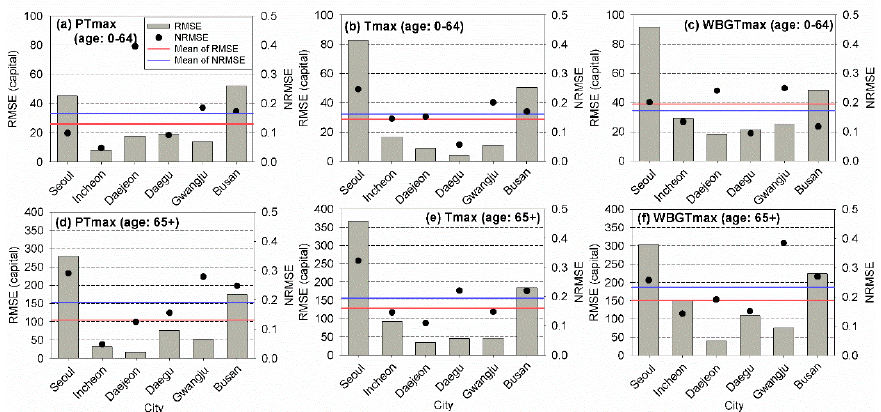
Figure 10. Root-mean-square error (RMSE) and normalized RMSE of the observed and estimated annual total mortalities young people with ( a ) PTmax, ( b ) Tmax, and ( c ) WBGTmax and elderly people with ( d ) PTmax, ( e ) Tmax, and ( f ) WBGTmax for the six cities and young (0–64) and elderly (64 + ) people for the test period (2017–2018).